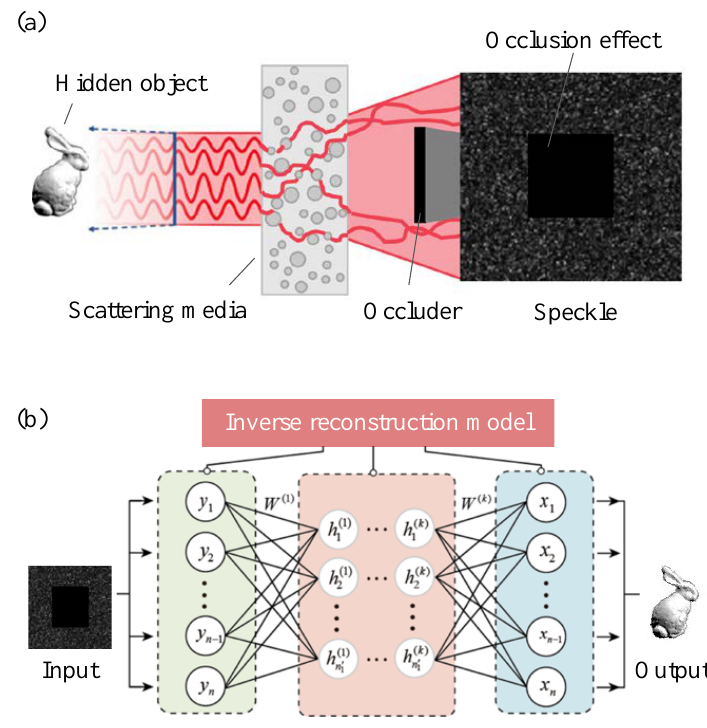
Figure 1. Sketch map of scattering-assisted imaging across in-line-of-sight opaque barriers. ( a ) the scattering-assisted imaging system. ( b ) the inverse reconstrcution